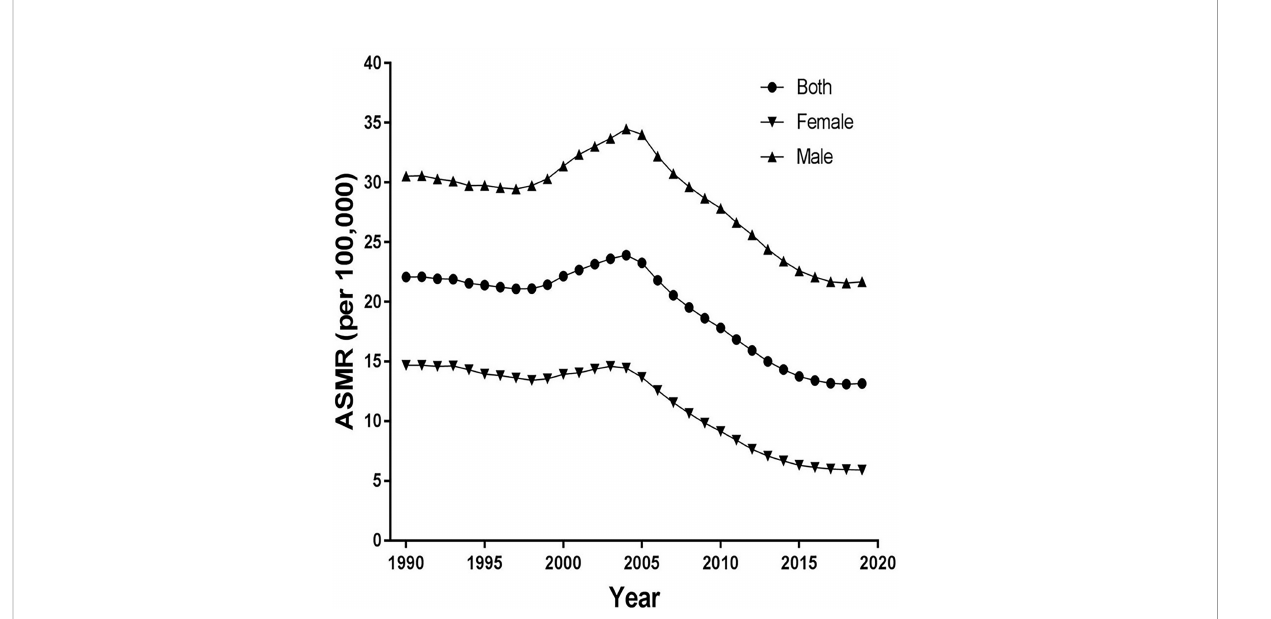
FIGURE 2 Trends of the age-standardized mortality rates (ASMR) for esophageal cancer from 1990 to 2019 in China.